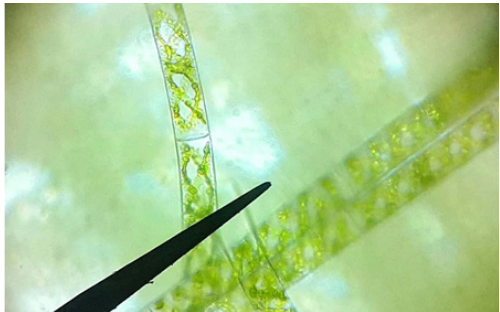
Fig. 1. Spirugera sp. (X400) Fig. 2. Severe infected with hydatid cyst in liver of